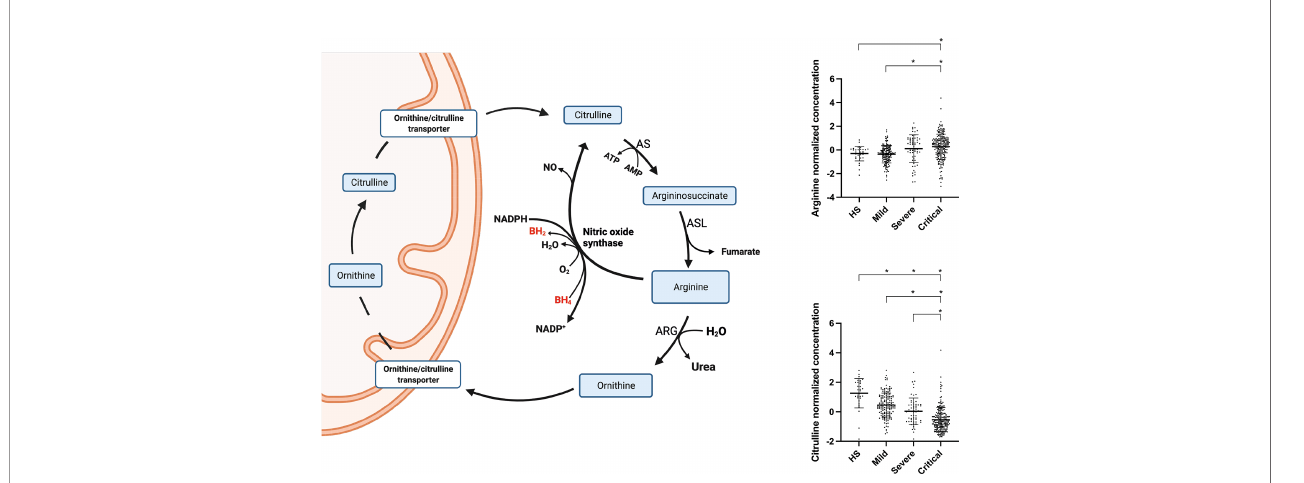
FIGURE 6 | Arginine and citrulline metabolic pathways and observed changes in COVID-19 patients. BH4, Tetrahydrobiopterin; BH2, Dihydrobiopterin; B6, Pyridoxine; HS, Healthy subjects; PHE, Phenylalanine; TYR,